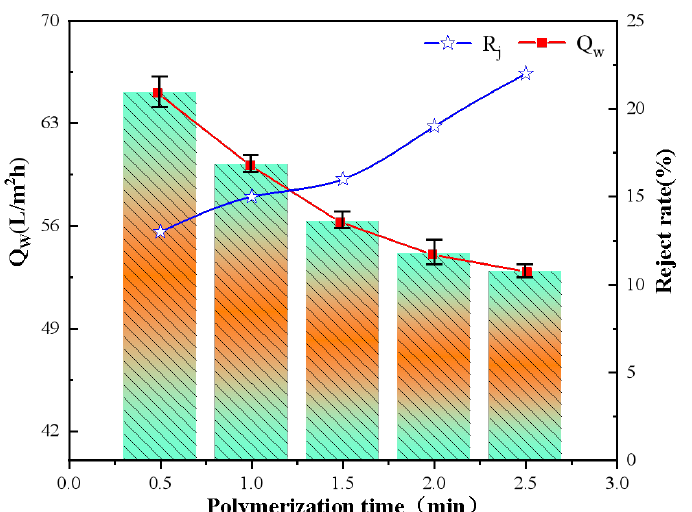
Figure 5. Influence of IP reaction time on on the water flux (Q w ) and salt filtration performance (R j ) of NFMs.